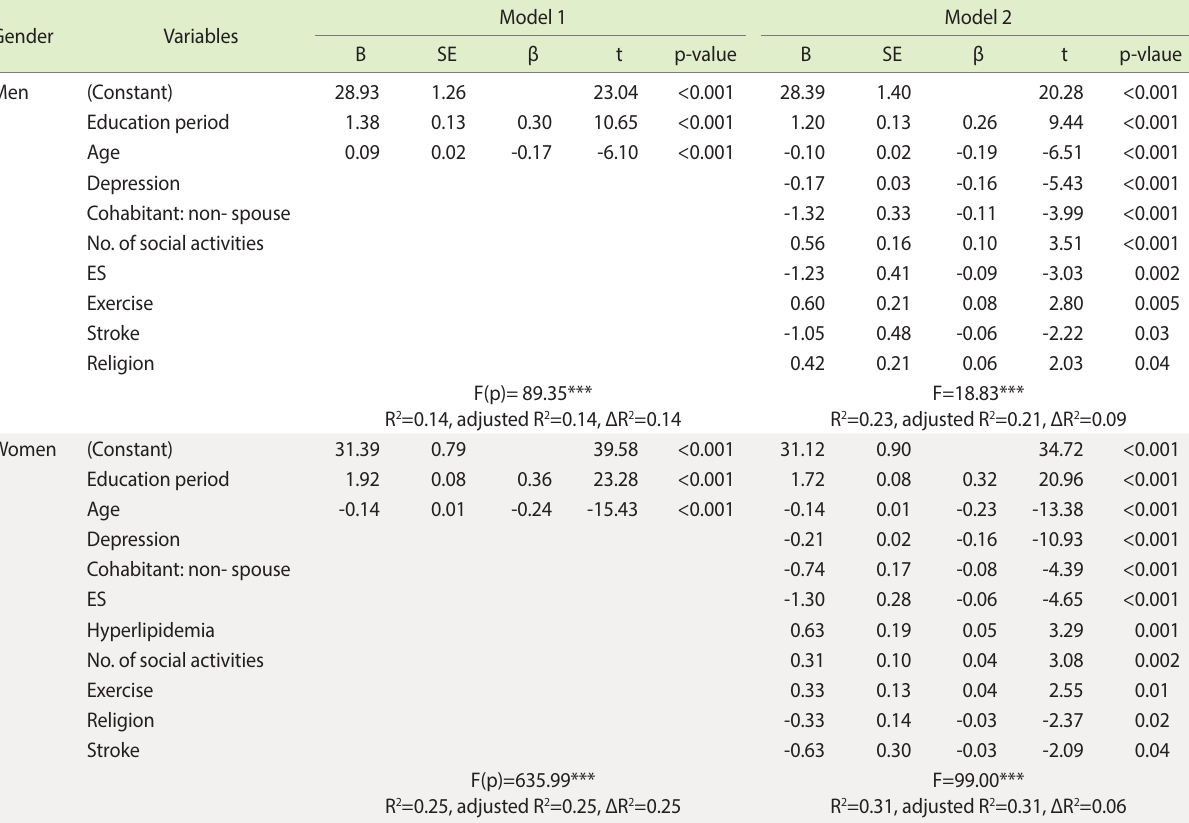
Table 4. Factors influencing cognitive function according to gender